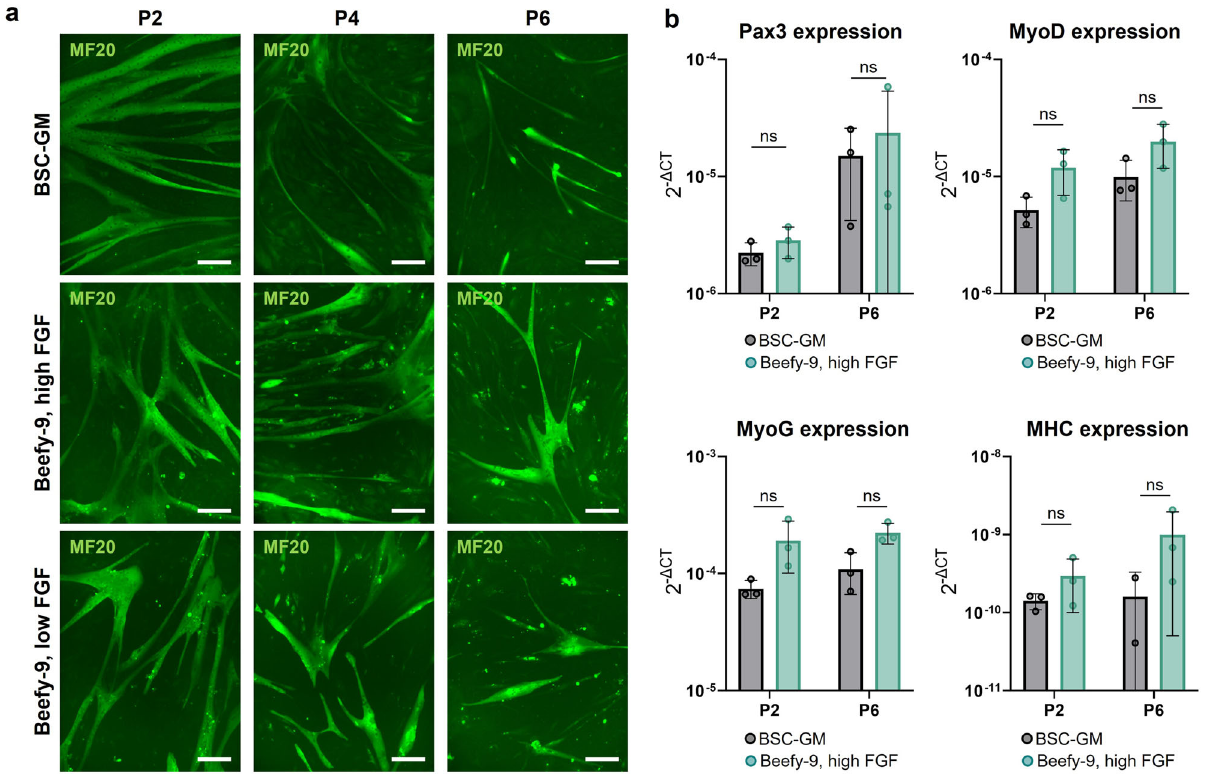
Fig. 6 BSC Myogenicity over long term culture. a Immuno fl uorescent staining for Myosin Heavy Chain (MF20, green) in BSCs at passages 2, 4 and 6 in various media. Cells were cultured to con fl uency and differentiated in a serum-free differentiation medium as previously described. Images revealed that myogenicity of BSCs was maintained throughout long term culture in both serum containing and serum-free media. Scale bars are 200 μ m. b Quantitative PCR for Pax3, MyoD, Myogenin (MyoG) and Myosin Heavy Chain (MHC) expression in differentiated cells shows no signi fi cant difference between media types. Results are supported by immuno fl uorescent staining for these markers (Fig. S6). n = 3 distinct samples; statistical signi fi cance was calculated via two-way ANOVA with multiple comparisons between